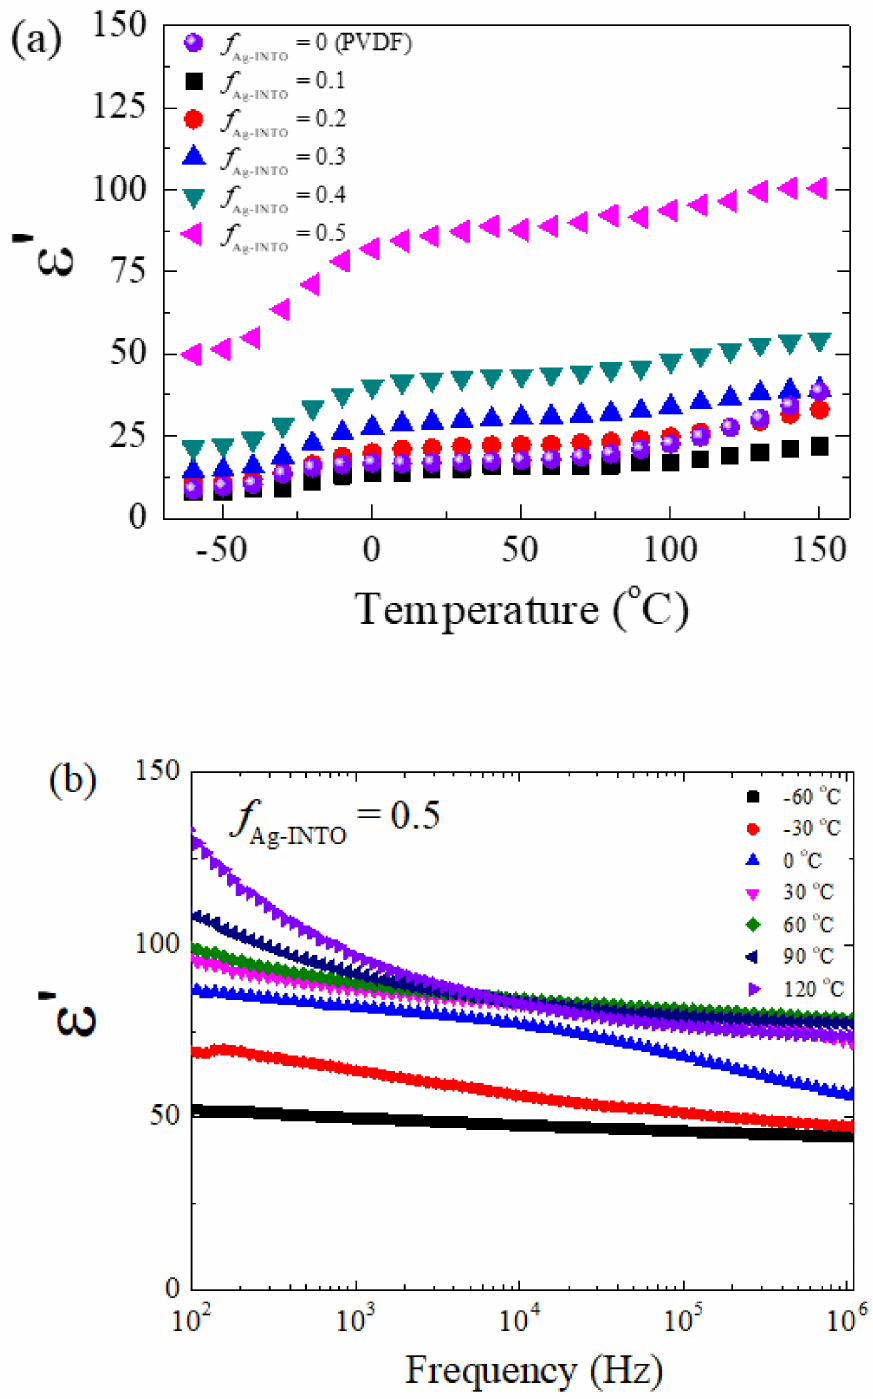
Figure 6. ( a ) Temperature dependence of ε (cid:48) at 1 kHz for PVDF polymer and Ag − INTO/PVDF composites with different f Ag − INTO values. ( b ) Frequency dependence of ε (cid:48) at different temperatures for Ag − INTO/PVDF composite with f Ag − INTO =